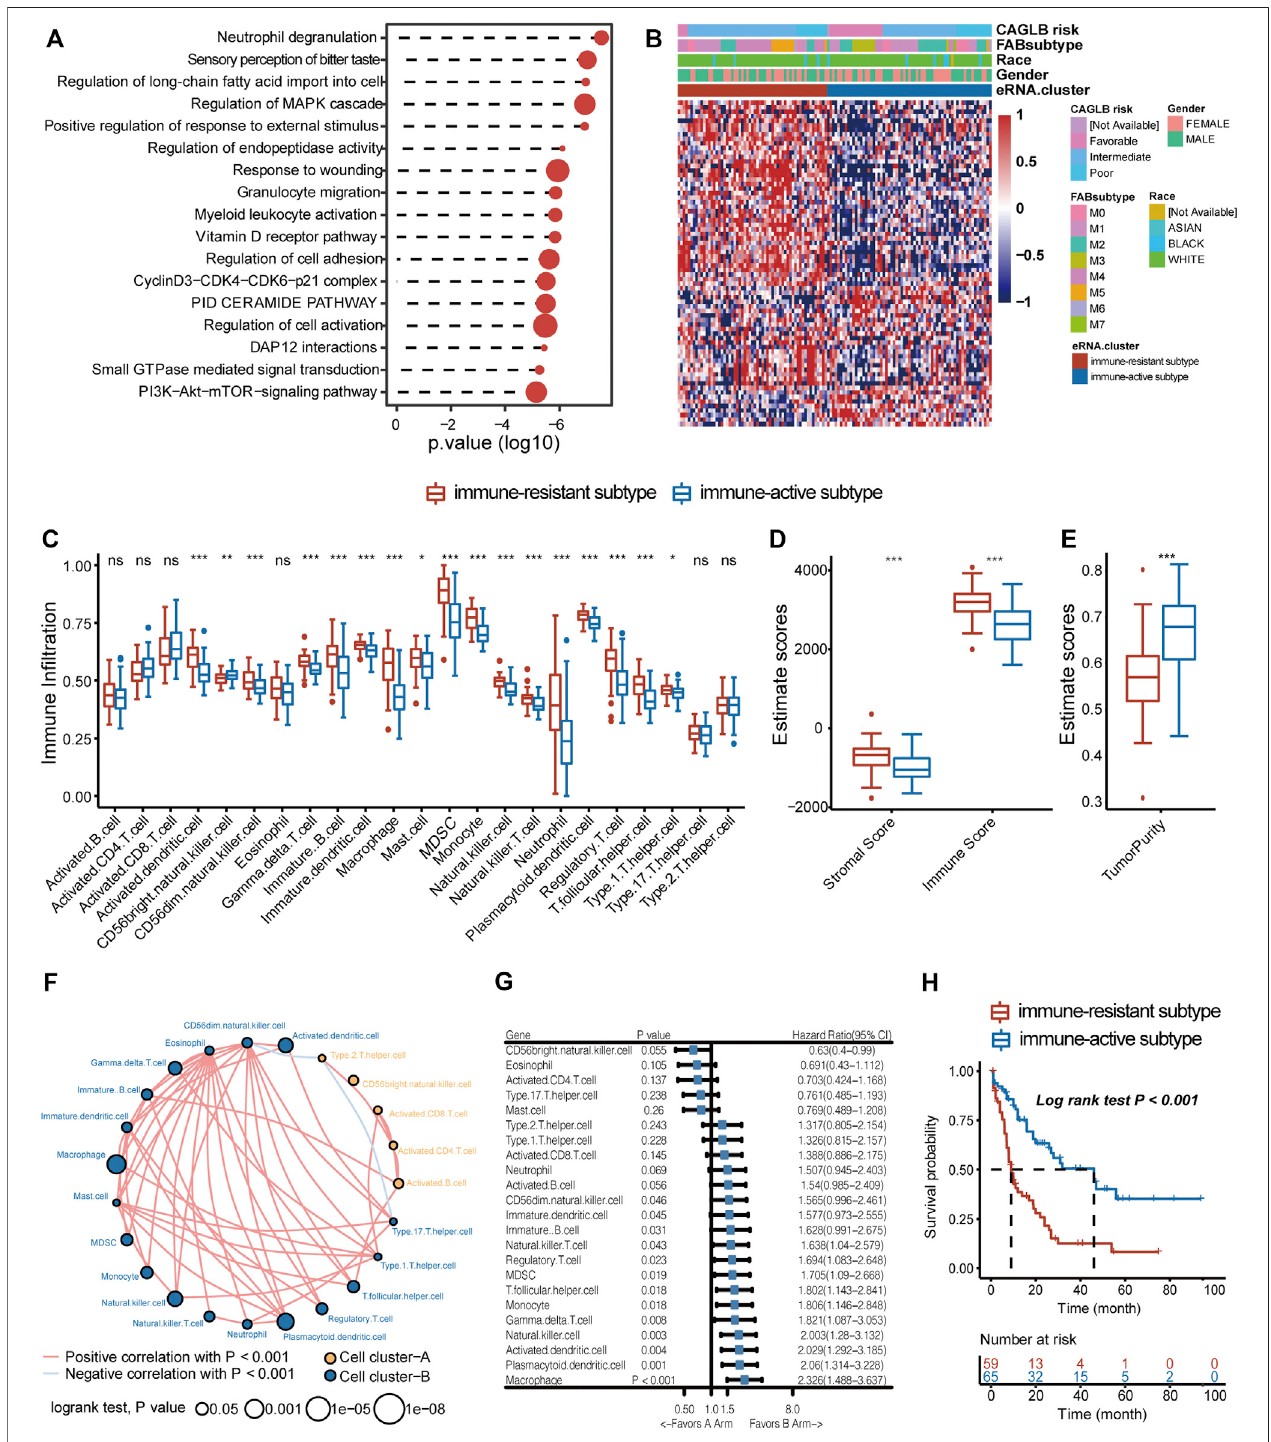
FIGURE 3 | ir-eRNAs regulate the development of the tumor microenvironment in the bone marrow. (A) GO analysis of 258 prognostic eRNAs showed immune- related functional activation. (B) Two eRNA clusters showed different clinical and gene expression characteristics, illustrated by a heatmap. (C) Analysis of the immune in fi ltrationlevelof23immunecellsubtypesintwoeRNAclusters(ns, p > 0.05,* p < 0.05;** p < 0.01;*** p < 0.001,Wilcoxontest). (D) ESTIMATEscoreofstromal,immune components in the TMEin twoeRNA clusters(Wilcoxon test, *** p < 0.001). (E) ESTIMATE score oftumor purity intwoeRNA clusters (Wilcoxon test, *** p < 0.001). (F) Cellclusteringrevealedcorrelationsamong23immunecellsubtypes(Spearmancorrelation, p < 0.001,log-ranktest, p < 0.05). (G) UnivariateCoxregressionshowed prognostic relevance of different immune cell in fi ltrations. (H) Survival analysis showed different survival outcomes between two eRNA clusters (log-rank test p < 0.001).